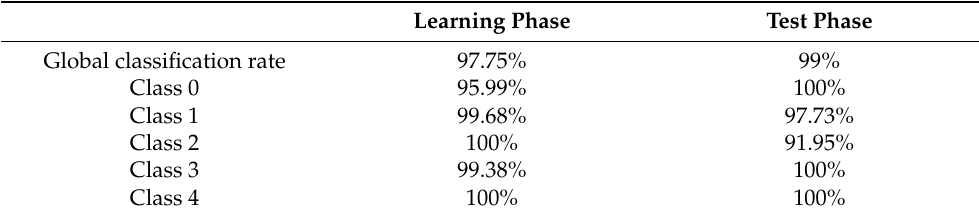
Table 6. Classification results